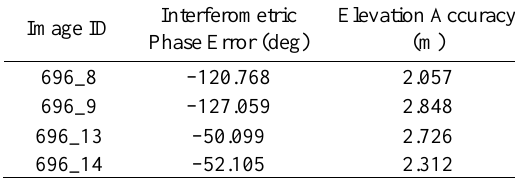
Table 3. Evaluation accuracy after interferometric phase